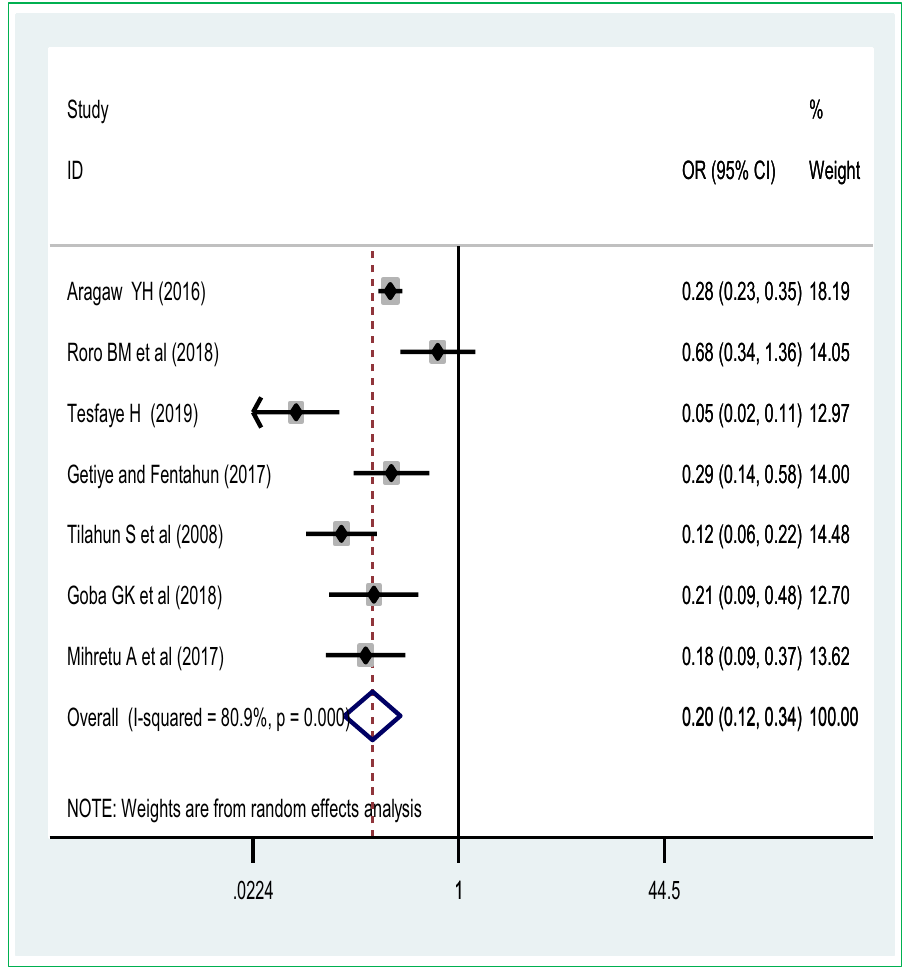
Figure 5. Pooled odds ratio on the association of antenatal care visit and perinatal